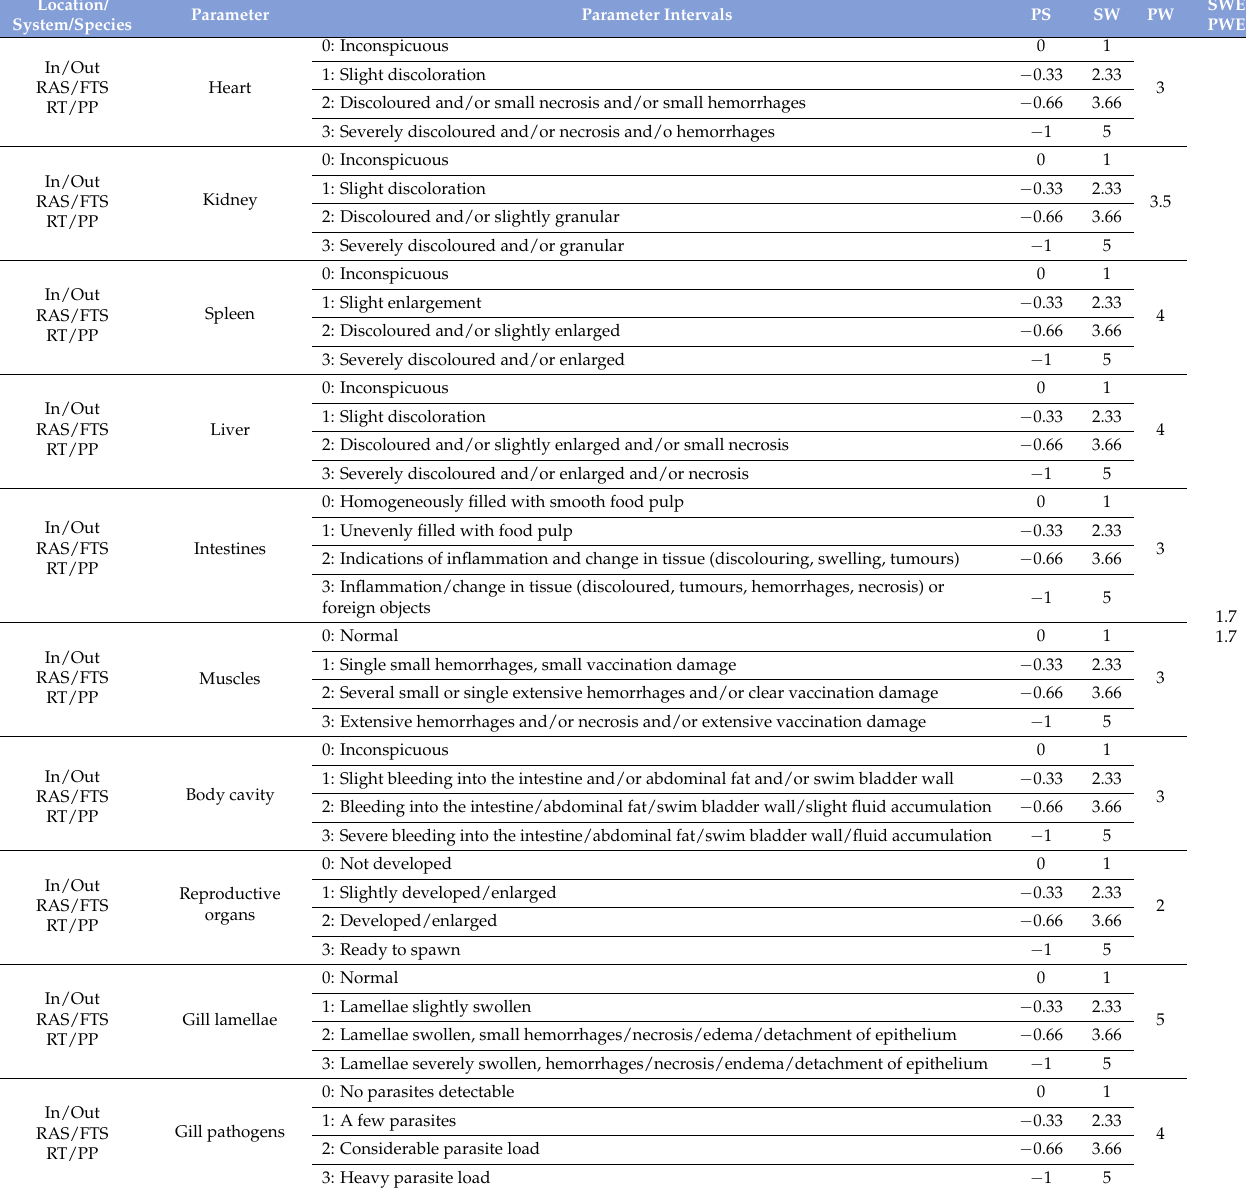
Table A7. Module fish internal appearance. In = indoor, Out = outdoor, RAS = recirculating aquaculture system, FTS = flow-through system, RT = rainbow trout, PP = pikeperch, PS = parameter score, SW = score weight, PW = parameter weight, SWE = score weight exponent, PWE = parameter weight